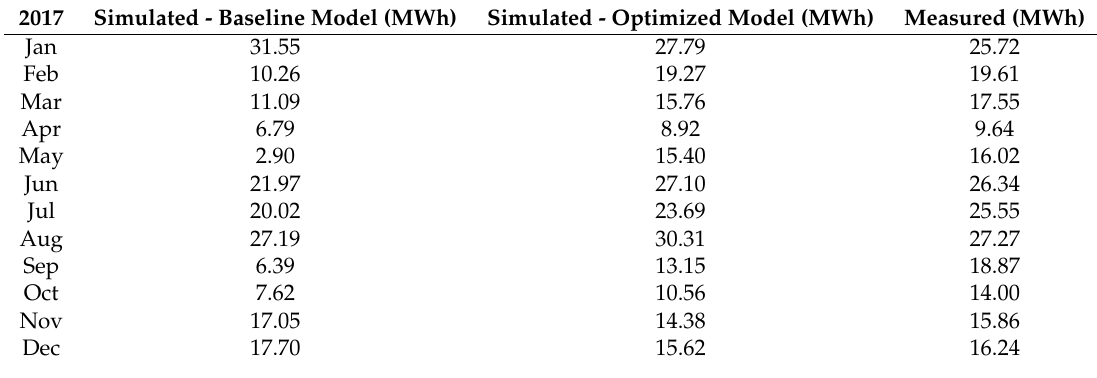
Figure 5. Measured total HVAC electrical energy consumption for the year 2017 versus: ( a ) initial model (baseline) ( left plot ) and ( b ) parameterized model (optimized) ( right plot ). Table 1 contains monthly measured HVAC electrical energy consumption values and the corresponding simulated ones obtained from the baseline and optimized models for 2017. Table 1. Monthly measured HVAC electrical energy consumption values and the corresponding simulated ones obtained from the baseline and optimized models for